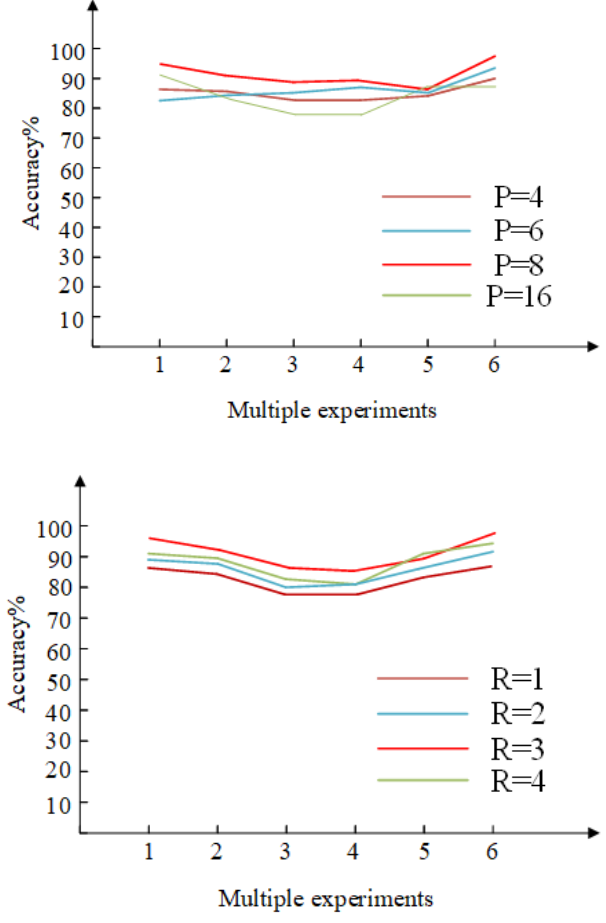
Figure 9. Recognition accuracy under different LBP parameters.